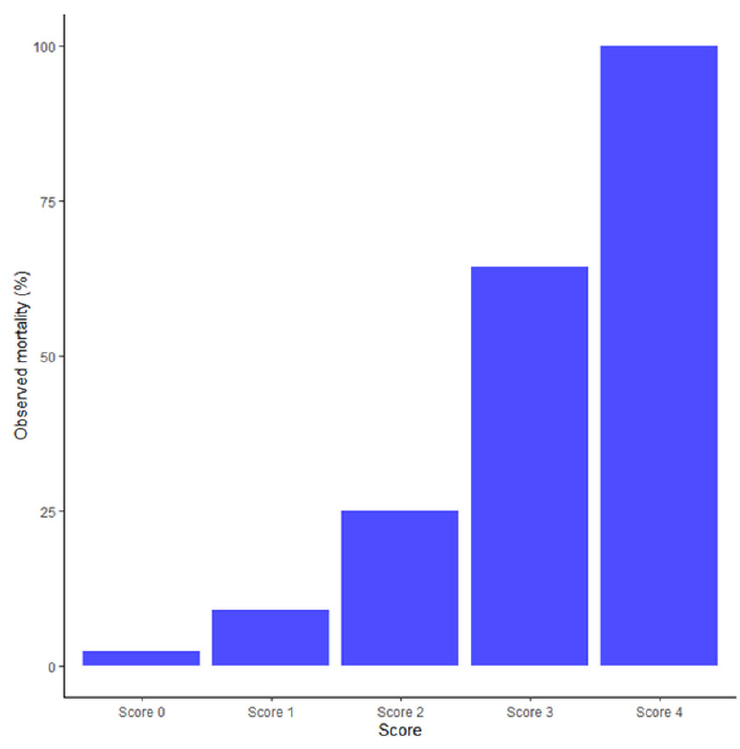
Figure 1. Probability of in ‐ hospital mortality according to the CoBiF score.